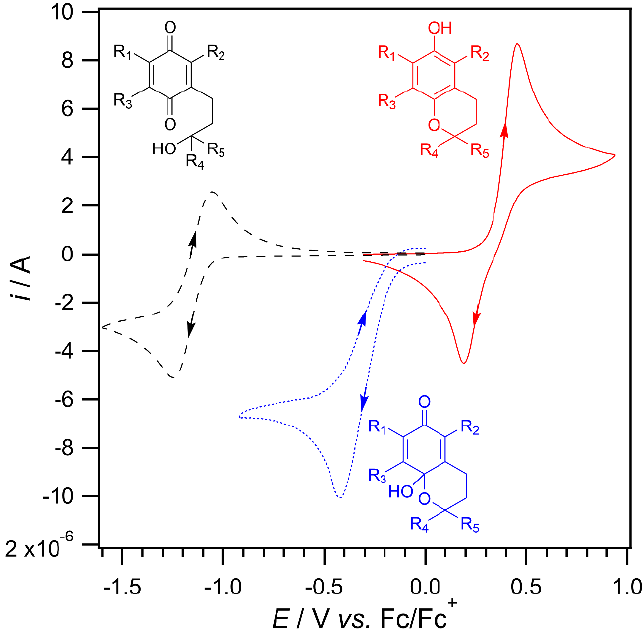
Figure 5. Representative voltammograms for oxidation of chroman-6-ol (red) and reduction of its associated hydroxy para –quinone hemiketal (blue) and para –quinone (black).